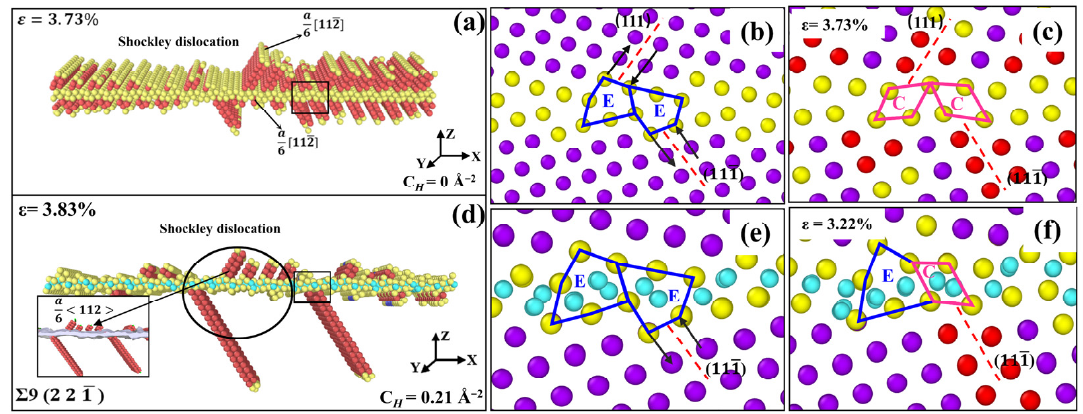
Figure 11. MD snapshots of dislocation nucleation from Ni bicrystal with Σ 9 (2 2 1) STGB without and with H. ( b , c , e , f ) Enlarged images for nucleation region of the boundary marked in ( a , d ), respectively. For the Σ 3 (1 1 1) STGB, the GB energy is the lowest of all